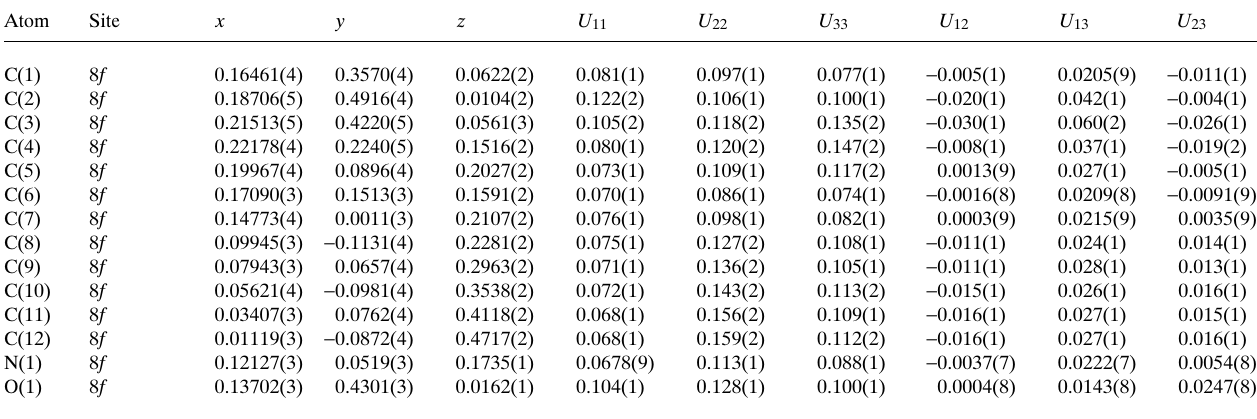
Table 3. A tomic coordin a tes a nd displ a cement p a r a meters (in Å 2 )